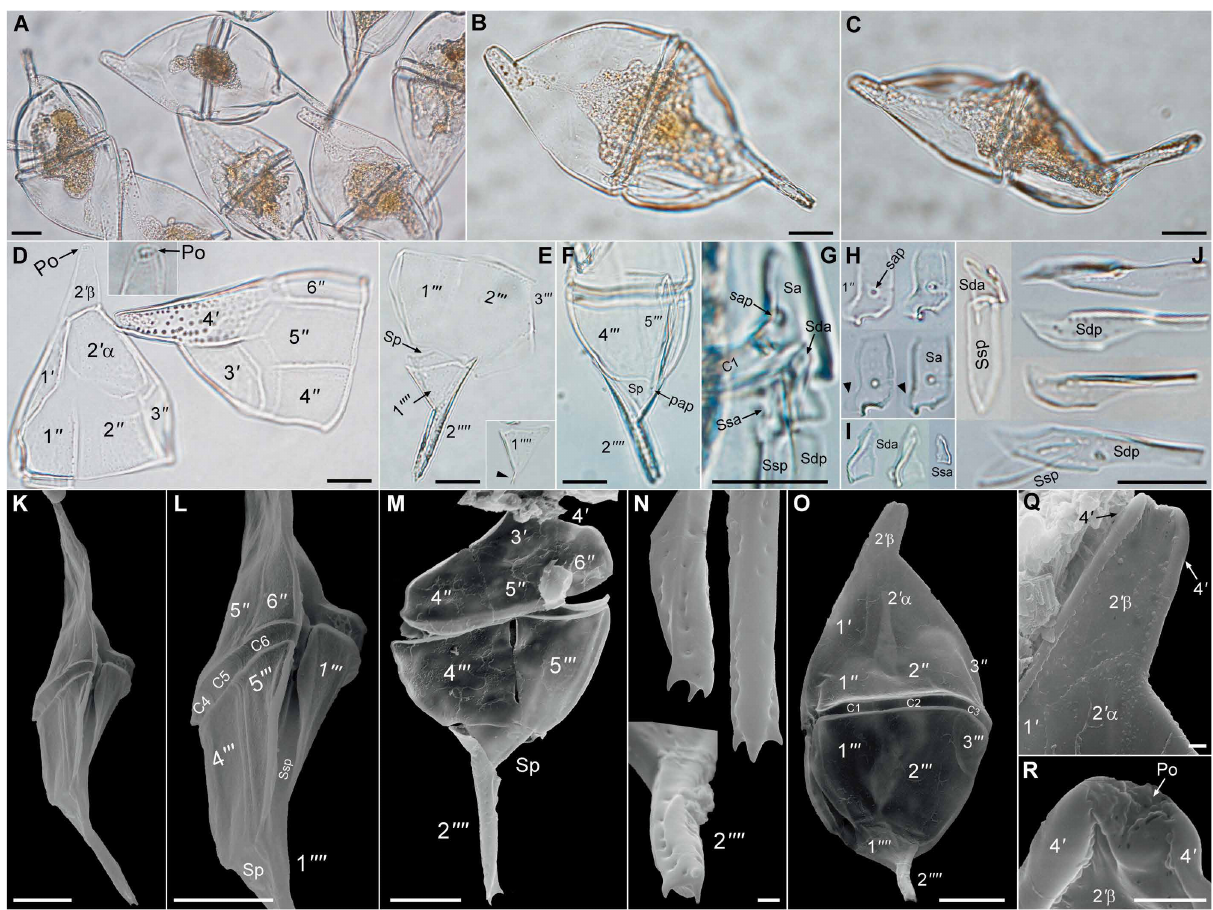
Figure 2: Light (a–j) and scanning electron (k–r) micrographs of Centrodinium intermedium . (a) Several individuals. (b) Left face. (c) Left- ventral view. Note the antapical horn oriented toward the left side. (d) Left and right faces of the same epitheca. The inset shows the apex. (e) Left hypotheca. The inset shows the first antapical plate. The arrowhead points a filiform extension. (f) Right hypotheca. (g) Detail of the sulcal area. (h) Dissociated anterior sulcal plates. The arrowheads point a membranous flange. (i) Anterior lateral sulcal plates. (j) Dissociated posterior lateral sulcal plates. (k–l) Ventral view. (m) Right face. (n) Different antapical horns. (o) Left face. (q–r) Detail of the apex.